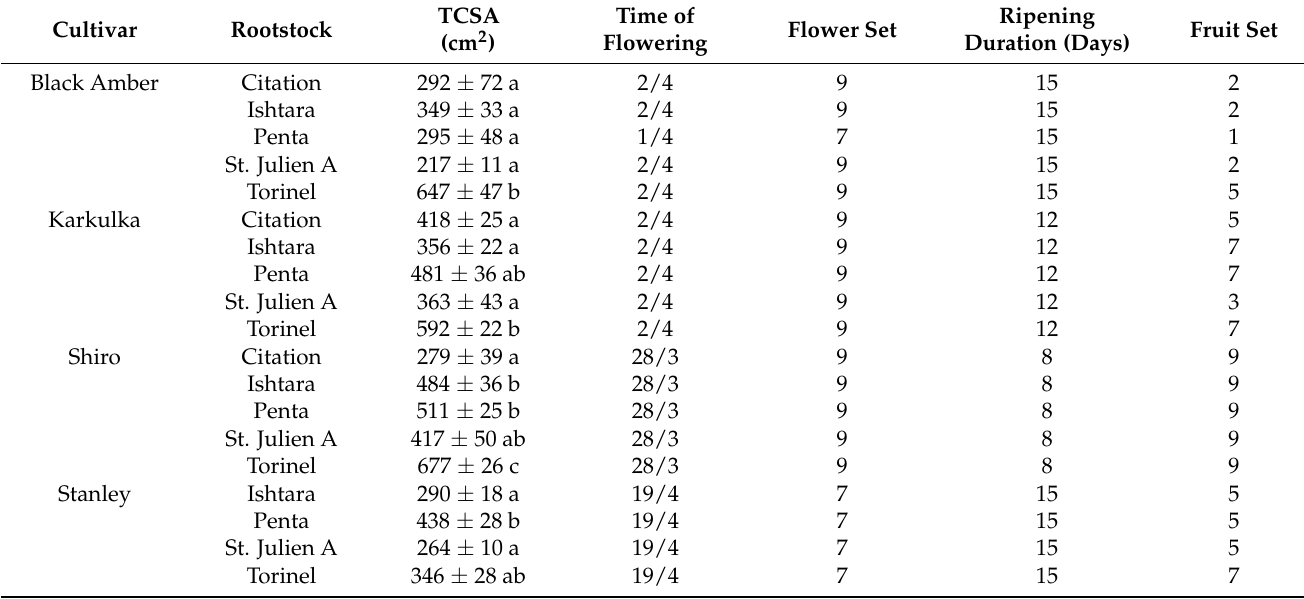
Table 1. The mean value of trunk cross-sectional area (TCSA) with standard deviation and pheno- logical data of plum cultivars grown on different rootstocks. Flower and fruit set was evaluated according to the scale from 1 (the lowest amount) to 9 (the highest amount).